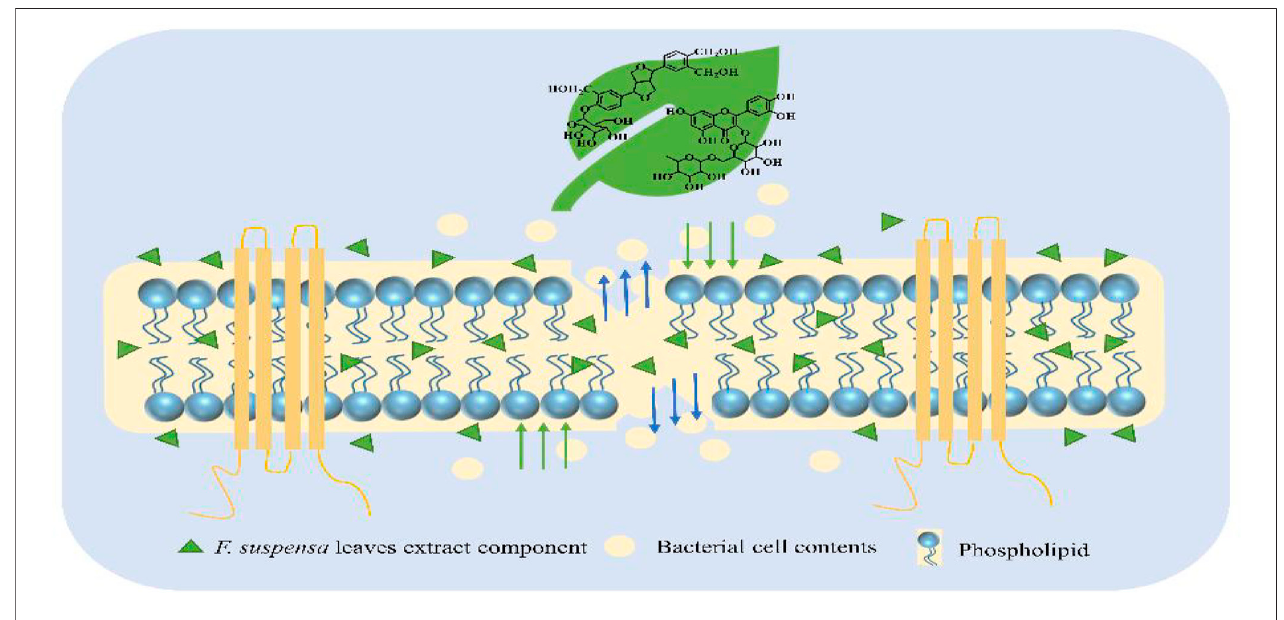
FIGURE 1 | Antibacterial mechanism of F. suspensa leaves